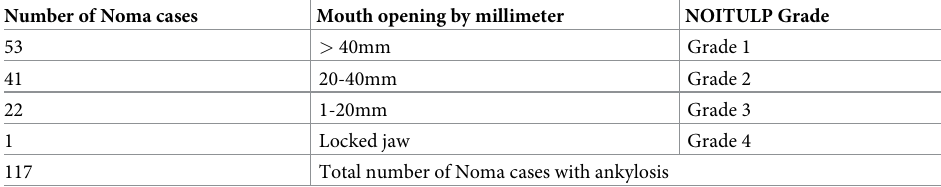
Table 3. Noma cases with different levels of mouth opening limitations (NOITULP Grade).